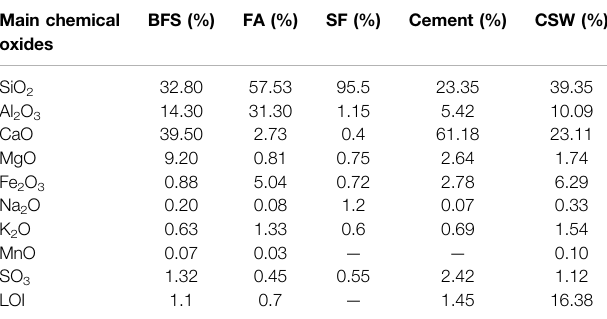
TABLE 1 | Chemical compositions of raw materials by